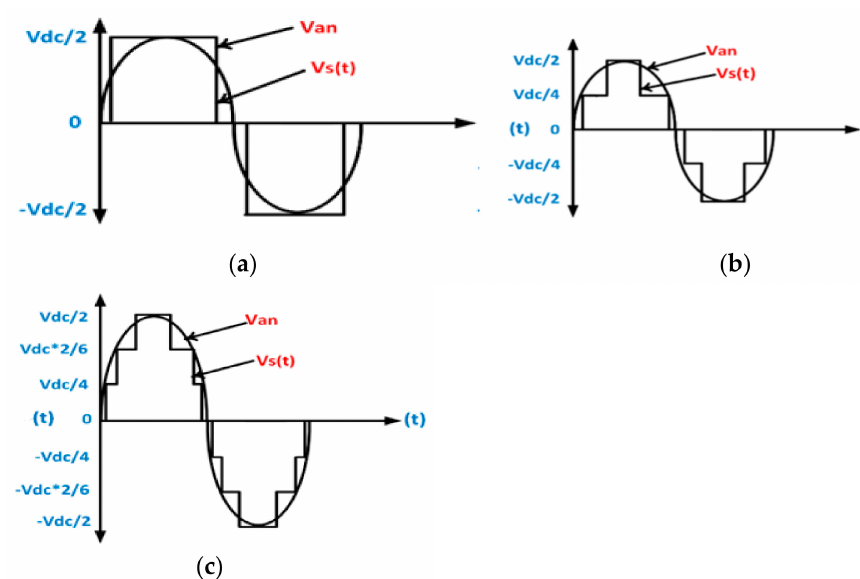
Figure 29. ( a ) Three-, ( b ) five-, and ( c ) seven-level (multilevel) waveforms [112].